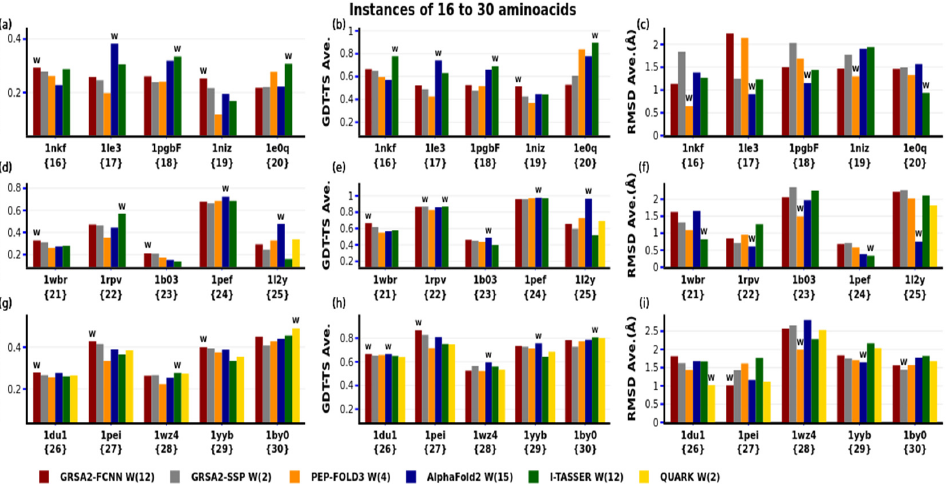
Figure 7. Comparison of GRSA2-FCNN versus I-TASSER, AlphaFold2, QUARK, PEP-FOLD3, and GRSA2-SSP (Instances of 16 to 30 aa). ( a , d , g ) show the average of the five best predictions of TM-score. ( b , e , h ) present GDT-TS for each instance, and ( c , f , i ) show the RMSD results.